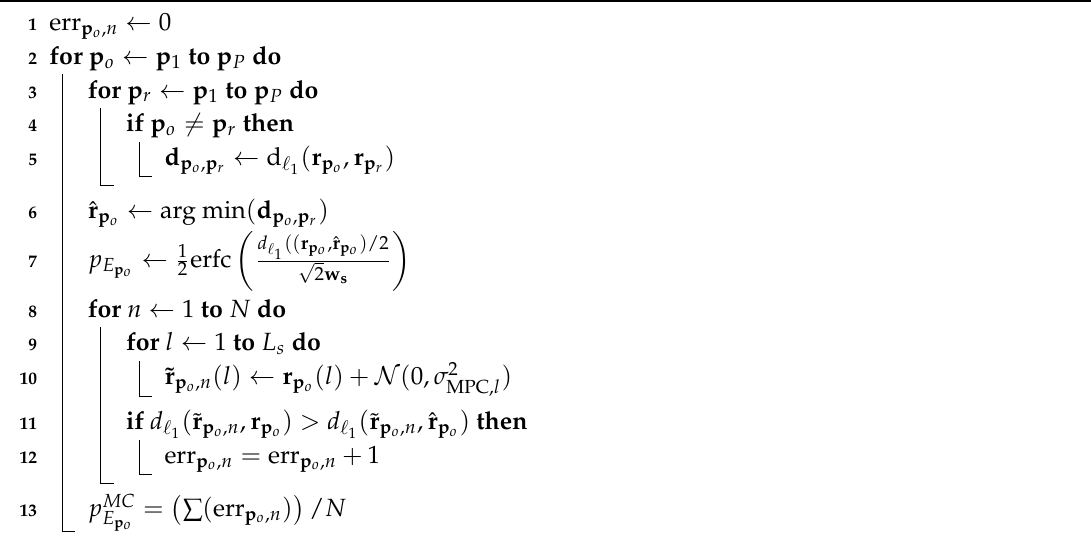
Algorithm 1: Pseudo-code for the error modeling and Monte-Carlo simulation c (cid:13) 2020 IEEE, Reprinted, with permission, from